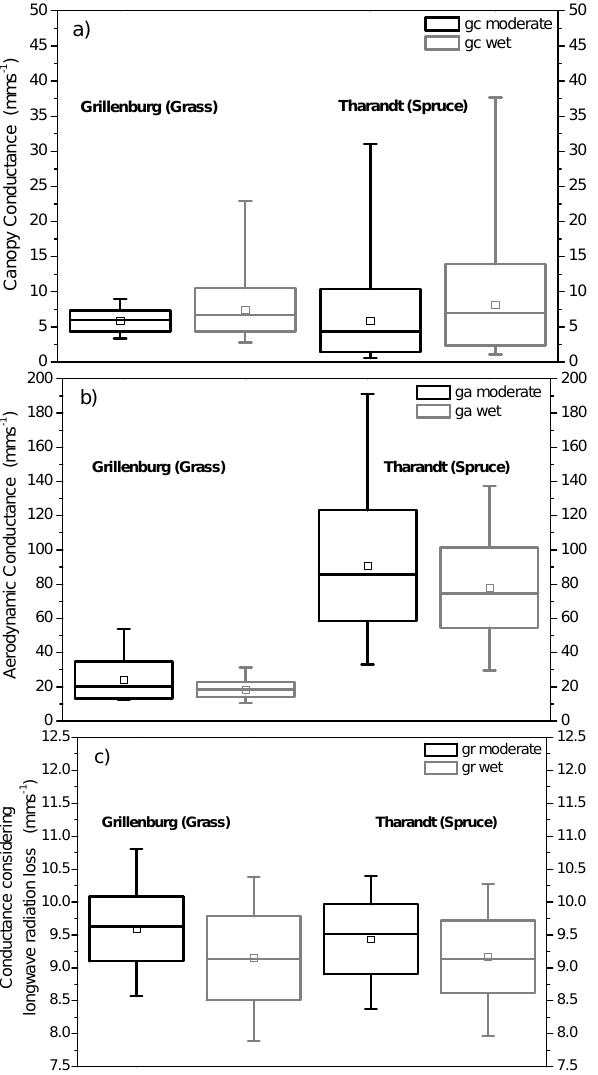
Fig. 3. Canopy (a) , aerodynamic (b) and long wave radiation trans- fer conductance (c) derived from measurements (half hour means) at the Anchor Station Grillenburg (grass, left side) and Tharandt (spruce, right side) during the summer season 2007 (for further in- formation see caption of Fig. 2).